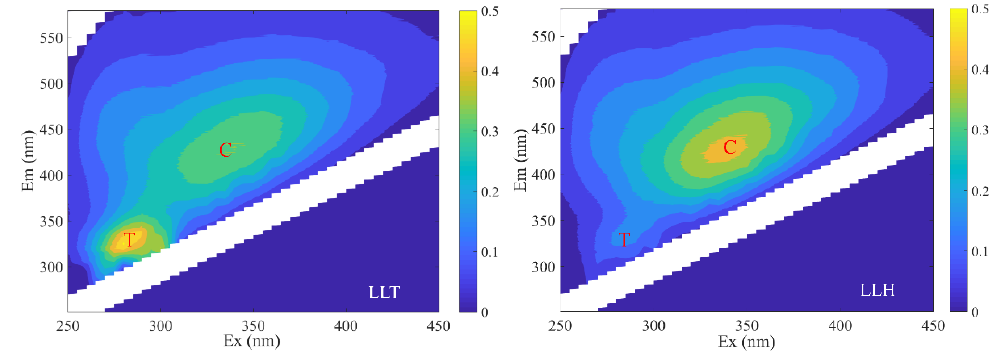
Figure 4. Examples of fluorescent excitation-emission matrix fluorescence spectroscopy (EEMs) spectra from water samples in the littoral zones of Lakes Taihu and Hongze, showing the presence of a humic-like DOM peak (Peak C) and a protein-like DOM peak (Peak T).